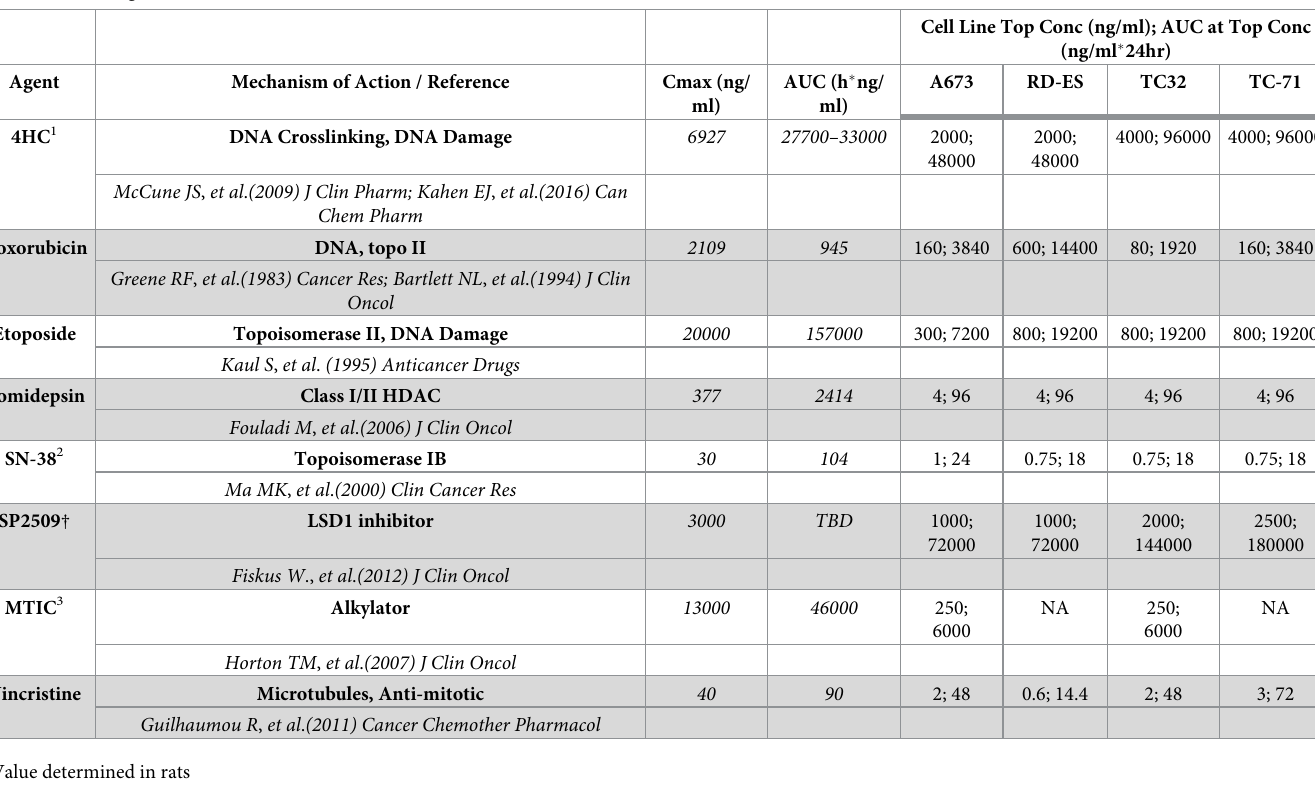
Table 1. Summary of agents tested, mechanism of action, selected pharmacokinetic data, and experimental values—top concentrations and AUC at top concentra- tions for each drug in each cell